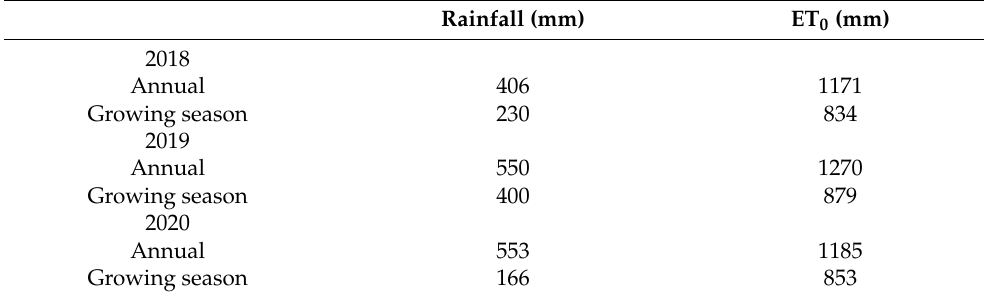
Figure 1. Flowchart of the methodology of this study carried out in a vineyard cv. Monastrell, located in south-eastern Spain. Table 1. Annual and growing season (from April to the end of September) rainfall and reference evapotranspiration (ET 0 ) values from the studied vineyard cv. Monastrell located in south-eastern